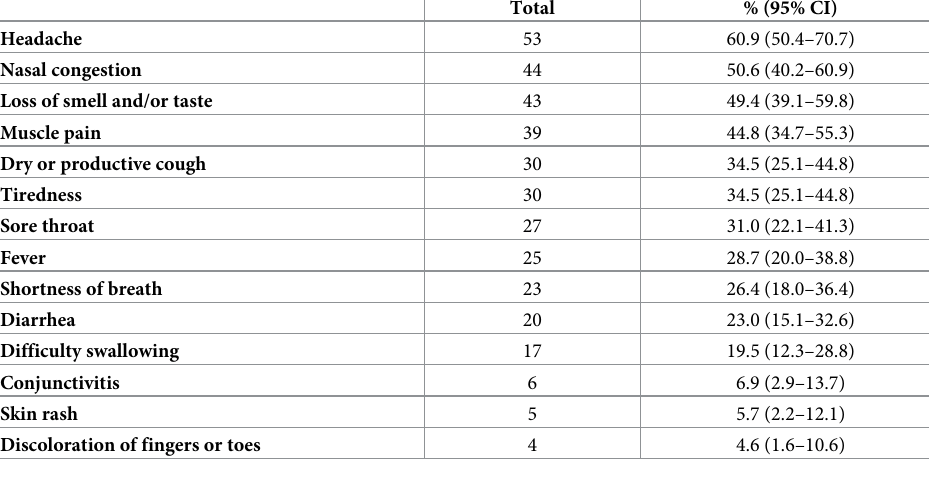
Table 4. Distribution of reported symptoms among symptomatic individuals with positive serology for SARS- CoV-2 (N =